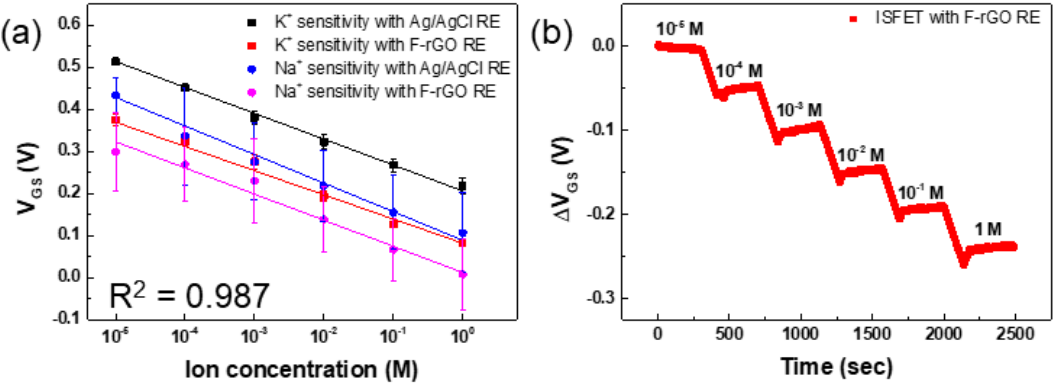
Figure 5. ( a ) Na + and K + ion sensitivities of the ITO − ISFET − ISM with the Ag/AgCl and F − rGO REs. ( b ) Real − time detection of K + ions using the ITO − ISFET − ISM with the F − rGO RE. Table 1. Other ion sensors using Ag/AgCl RE.